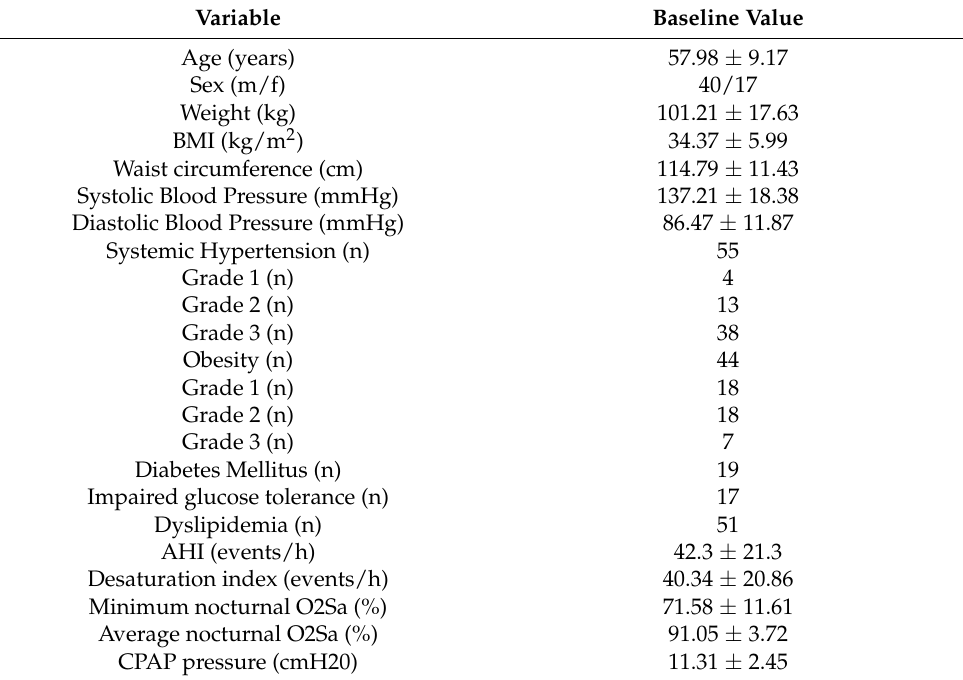
Table 1. Demographic and clinical characteristics of our study